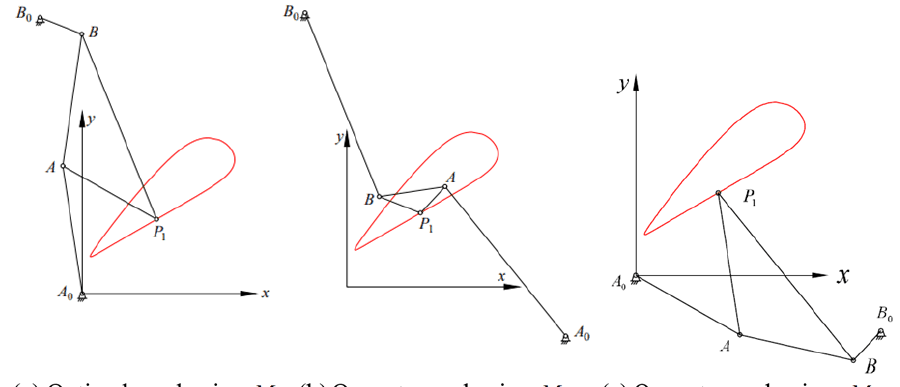
Figure 7. Optimal mechanism and two cognate